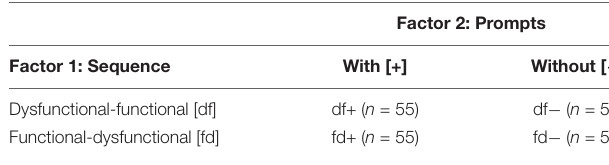
TABLE 1 | 2 × 2-factorial, experimental design.